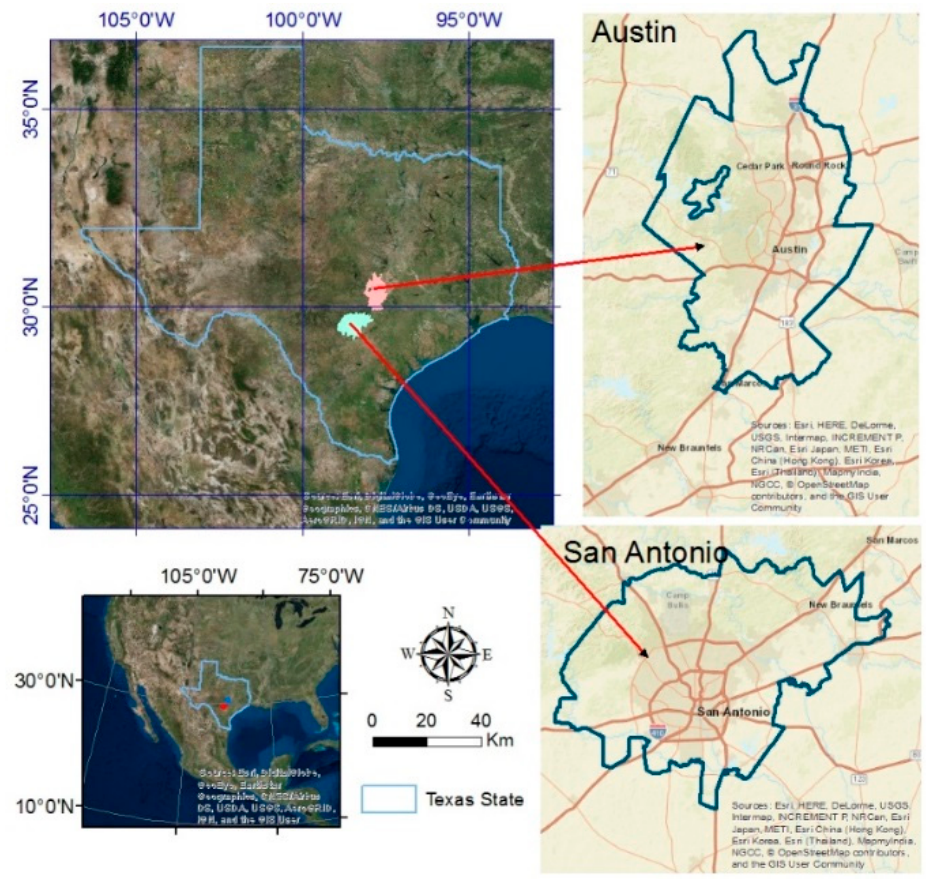
Figure 1. The Austin and San Antonio metropolitan areas in Texas, U.S.